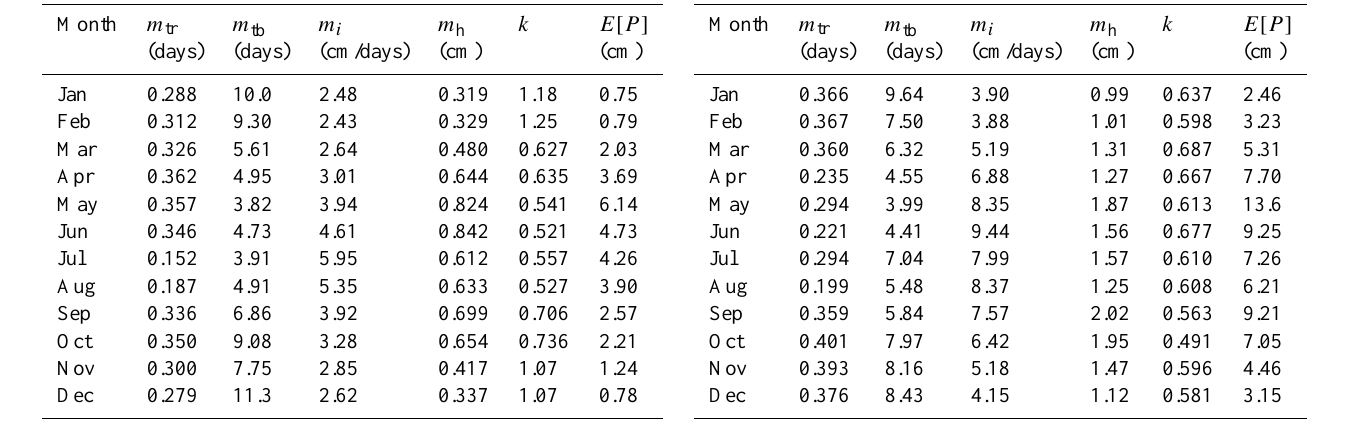
Table 3. PRP Model Statistics for the CPER. Table 4. PRP Model Statistics for the R-5